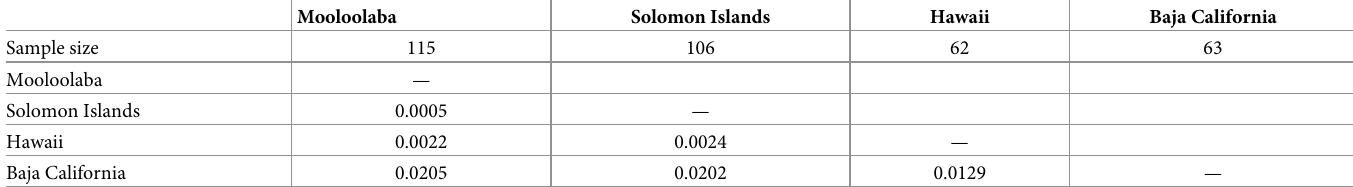
Table 1. Sample sizes (top row) and pairwise Fst for the different geographical locations. Fst values were calculated after cleaning of the genetic data and imputation of missing values (see Section